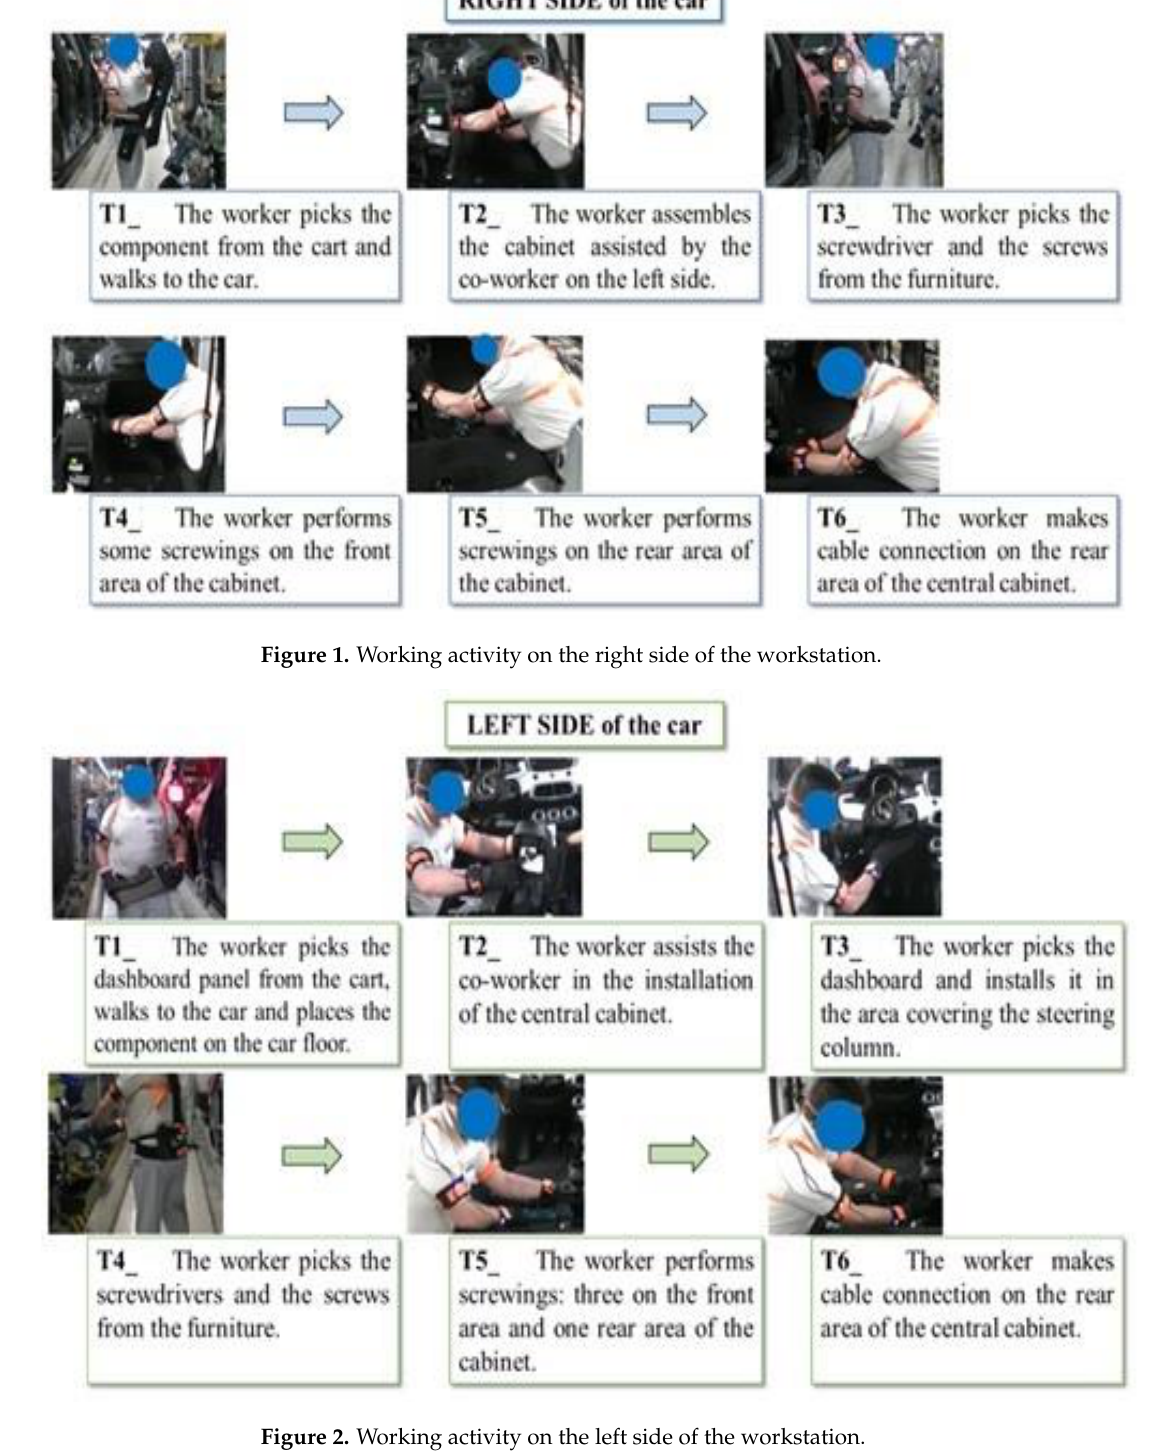
Figure 2. Working activity on the left side of the workstation.